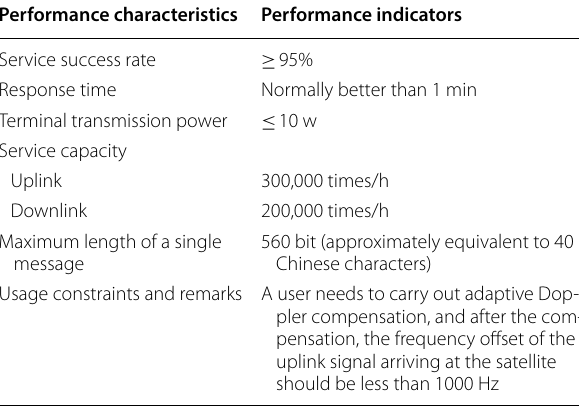
Table 4 Main BDS GSMC Service Performance Indicators Performance characteristics Performance indicators